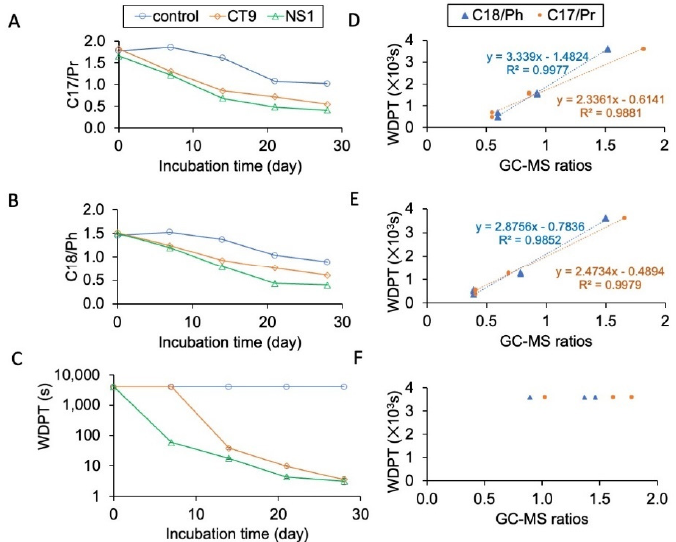
Figure 4. Changes in relative abundance ratios of ( A ) n-C17/pristane (n-C17/Pr) and ( B ) n- C18/phytane (n-C18/Ph) and ( C ). The correlation of ratios with log water-drop penetration time for NS1 ( D ), CT9 ( E ), and control ( F ) treatments during the 28-day